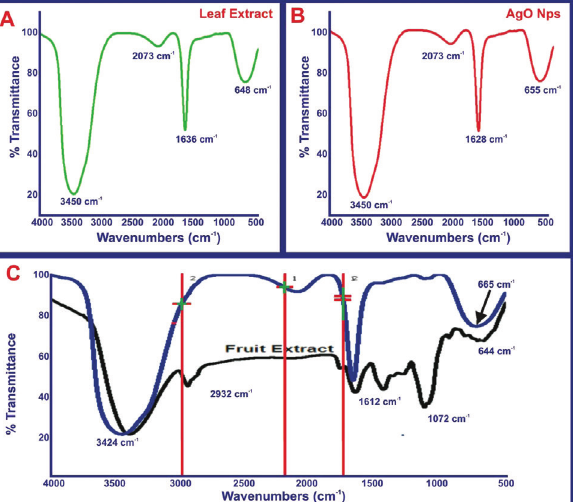
Figure 7: FTIR spectra of synthesized silver nanoparticles using (a) A. bilimbi leaf extract, (b) silver nanoparticle, (c) Plum fruit extract.